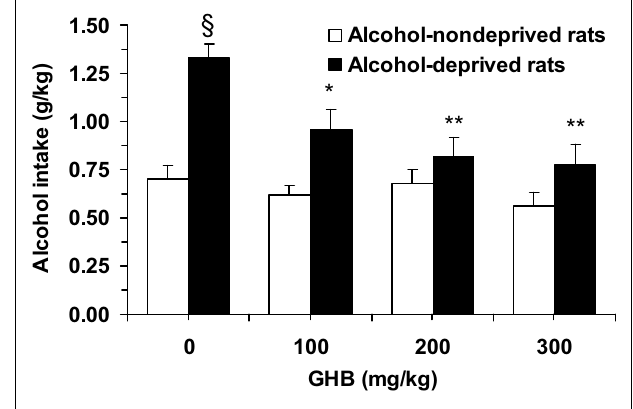
FIGURE 1 | Suppressing effect of the acute administration of γ -hydroxybutyric acid (GHB) on “alcohol deprivation effect” in Sardinian alcohol-preferring (sP) rats. Alcohol-deprived rats were initially allowed to consume alcohol (10% v/v, in water) and water under the homecage two-bottle choice regimen with unlimited access for 24h/day and four consecutive weeks, and then deprived of alcohol for 14 consecutive days; conversely, alcohol-non-deprived rats had continuous access to alcohol and water (with exception of the last 6h before GHB injection, when the alcohol bottle was removed to ensure that blood alcohol levels were equal to zero at the time of the test). Food pellets were always available. About 10–15min before representation of the alcohol bottle (which coincided with lights off), rats from both groups were injected with GHB (0, 100, 200, and 300mg/kg; i.p.). Alcohol intake was registered 60min after lights off. Each bar is the mean ± SEM of n = 8. S P < 0.0005 with respect to alcohol-non-deprived rats receiving 0mg/kg GHB (Newman–Keuls test); * P < 0.005 and ** P < 0.0005 with respect to alcohol-deprived rats receiving 0mg/kg GHB (Newman–Keuls